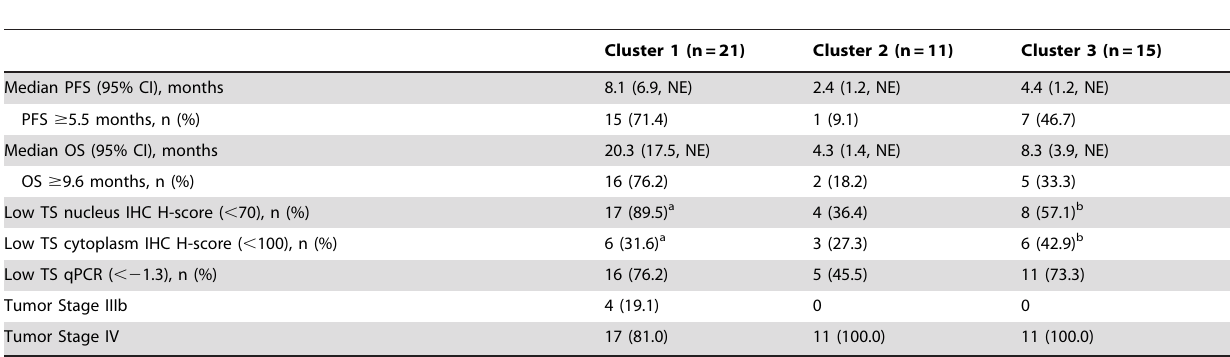
a based on n=19 patients with data available. b based on n14 patients with data available. Abbreviations: CI, confidence interval; IHC, immunohistochemistry; n, number of patients; NE, not estimable; NKX2-1, NK2 homeobox 1; NSCLC, non-small cell lung cancer; OS, overall survival; PFS, progression-free survival; qPCR, real-time quantitative polymerase chain reaction; TS, thymidylate